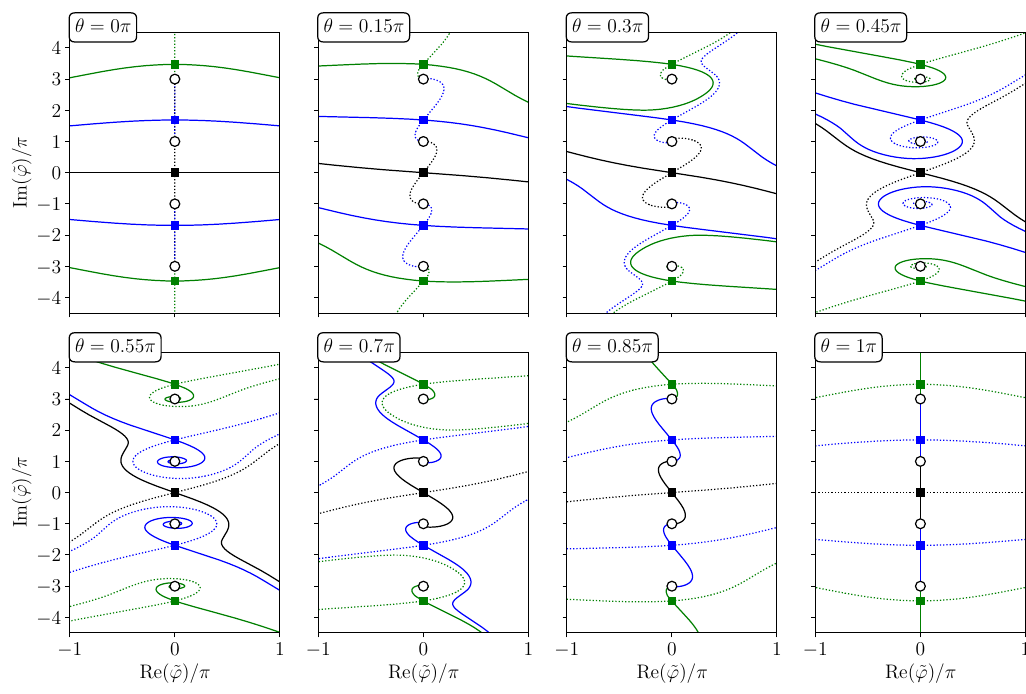
Figure 4 . Lefschetz thimbles and anti-thimbles of the one-variable effective action (3.34) for various values of b 2 = | b 2 | e − i θ , and η = 10 . The solid squares are the saddle points. The empty circles are the branch cut singularities of the log in the action. The solid curves are the thimbles (along which the real part of the action tends to + ∞ ; also known as steepest descent contours); the dashed curves are the anti-thimbles (along which the real part of the action tends to −∞ ). See figure 5 for further discussion on the behavior of the thimbles, in particular, whether they are equivalent to elementary